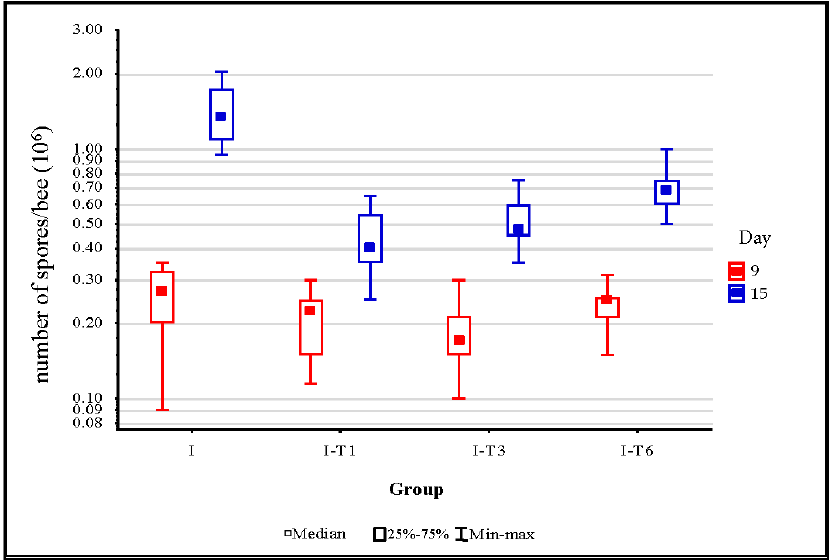
Figure 2. N. ceranae spore loads on day 9 and day 15 in bees from the control group and from groups infected and treated with thymol. Group infected with N. ceranae (I) and groups infected with N. ceranae and treated with thymol from day 1 (I-T1), day 3 (I-T3), and day 6 (I-T6).